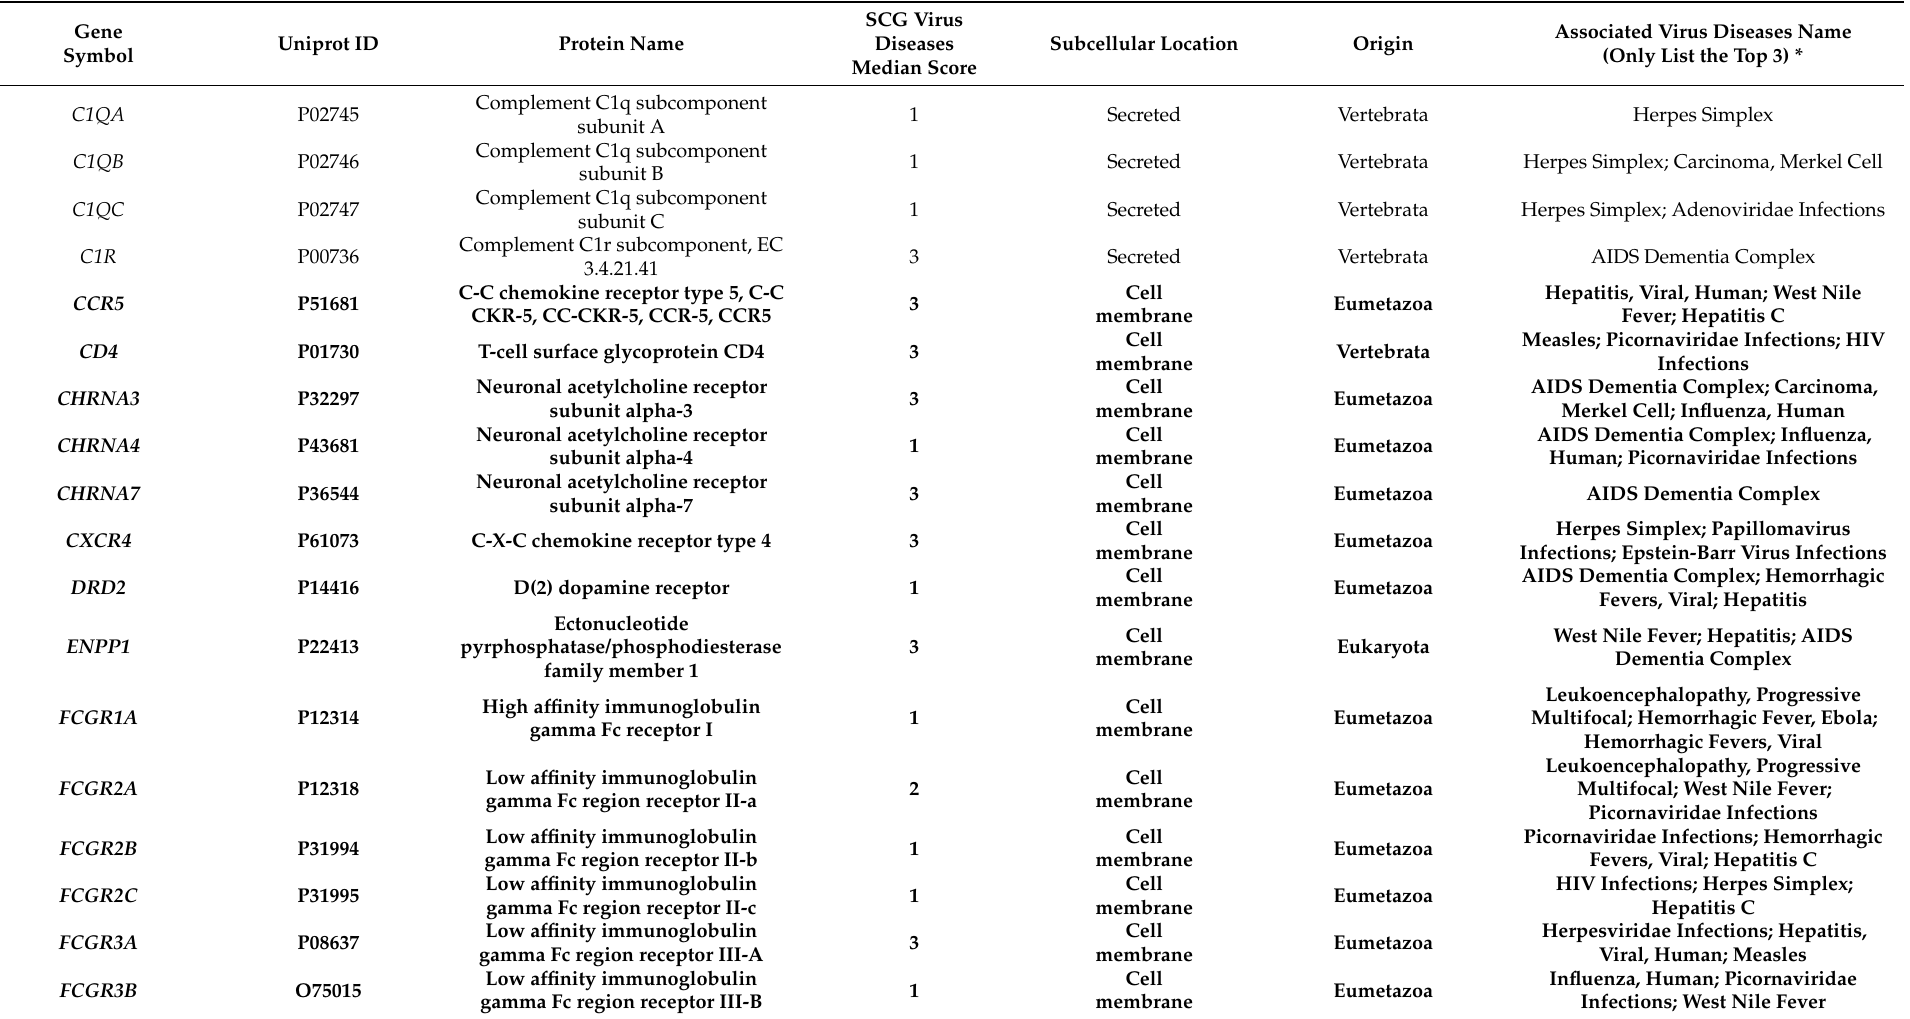
Table 1. Basic information of approved antiviral host